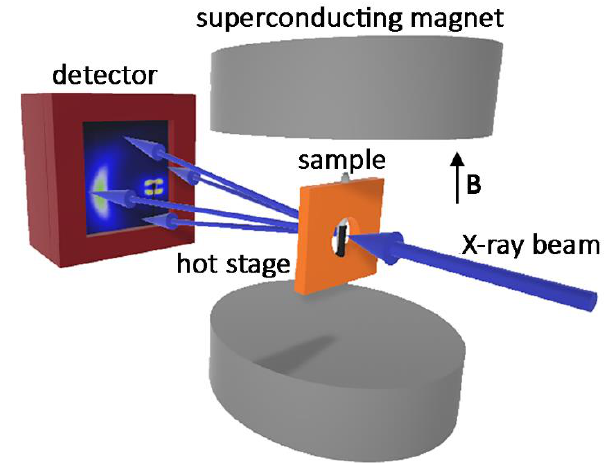
Figure 2. Experimental set-up for XRD measurements. The samples, placed in capillaries and mounted in the hot-stage, are aligned by a vertical magnetic field B . For small-angle measurements, characterized by a larger sample-to-detector distance, a vacuum chamber was placed between the sample and the detector to get rid of air